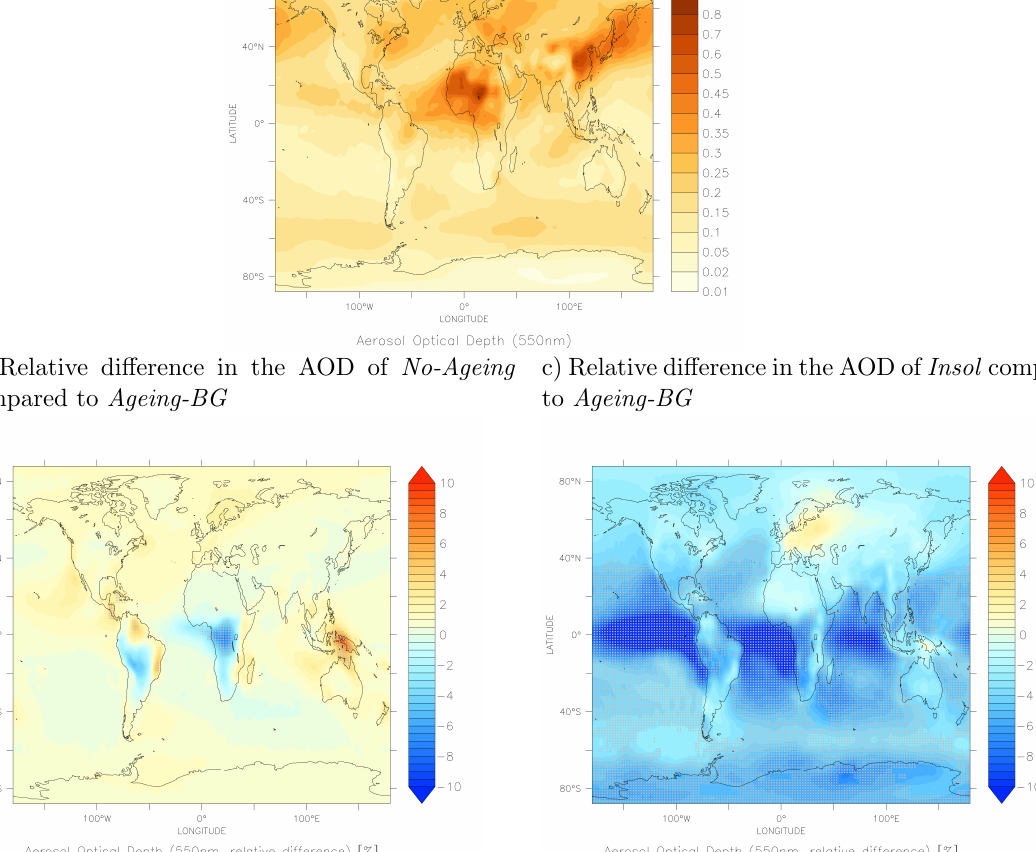
Fig. 8. Annual averages of the total aerosol optical thickness at a wavelength of 550nm. Panel (a) presents the absolute value for the Ageing- BG simulation. The panels (b) and (c) illustrate the relative differences of the No-Ageing and Insol simulations to the reference displayed above. In contrast to previous figures dotted areas mark regions of high statistical